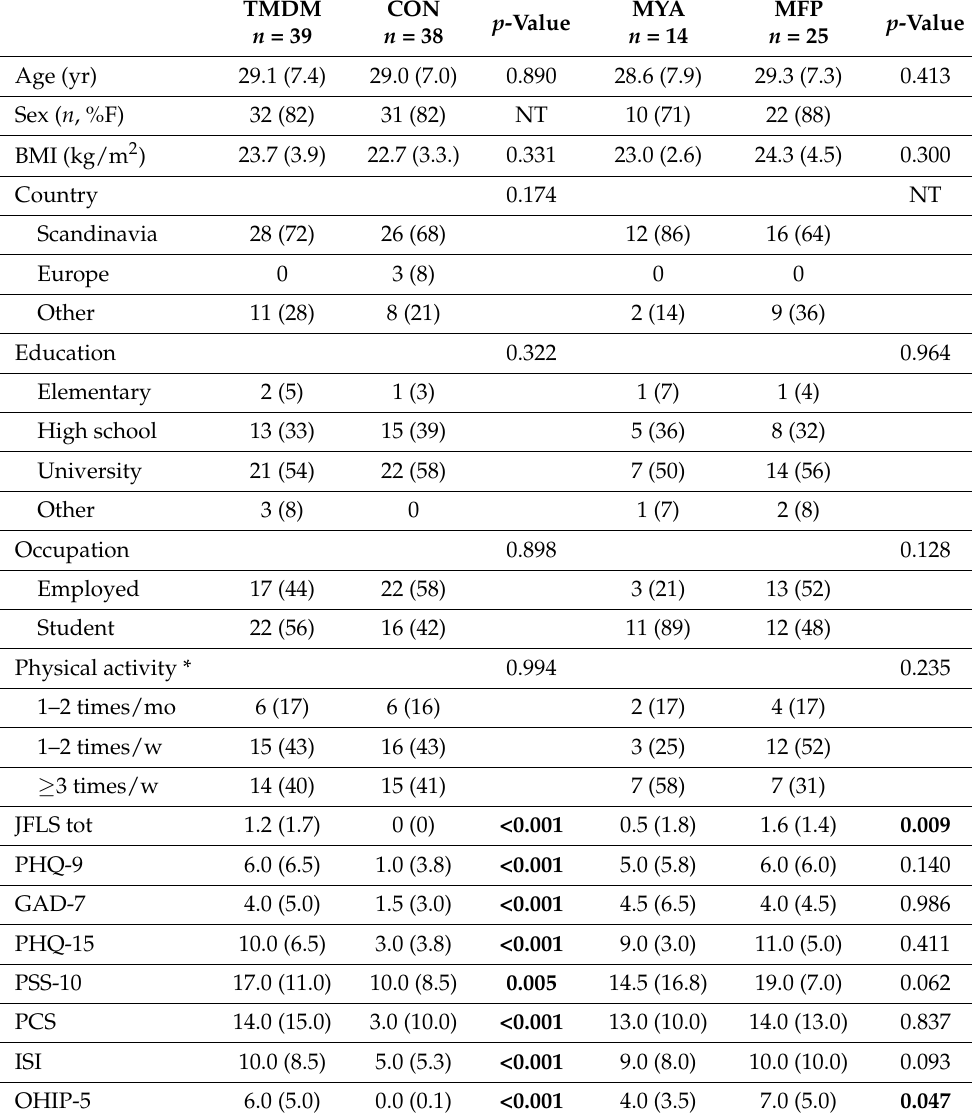
Table 1. Demographic data, physical function, and emotional function in patients with myogenous temporomandibular disorders (TMDM) and pain-free controls (CON) as well as in TMDM subgroups myalgia (MYA) and myofascial pain (MFP). Data show median (IQR) unless other is